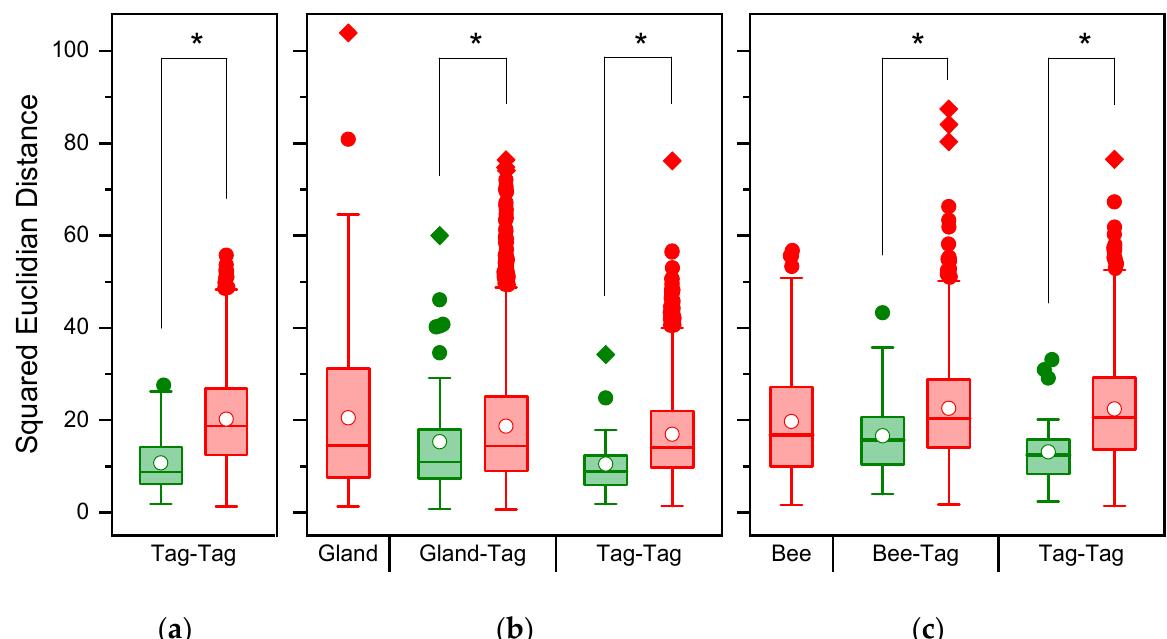
Figure 1. (Dis)-Similarity of chemical composition between scent tags of nests and origins of chemical compounds. The similarity is given as squared Euclidian distances, therefore, smaller values indicate a higher similarity. ( a ) Comparison of nest tags including all 59 substances; ( b ) Comparison of Dufour’s gland extracts (34 compounds) and nest tags. ( c ) Comparison of the estimated bee bouquet (49 compounds) and nest tags. Green: samples of one and the same bee, red: samples of different bees; boxes: 25th, 50th, and 75th percentiles, white dots: the mean; whiskers: the range of 1.5 IQR, colored dots: outliers, squares: extremes, * p <